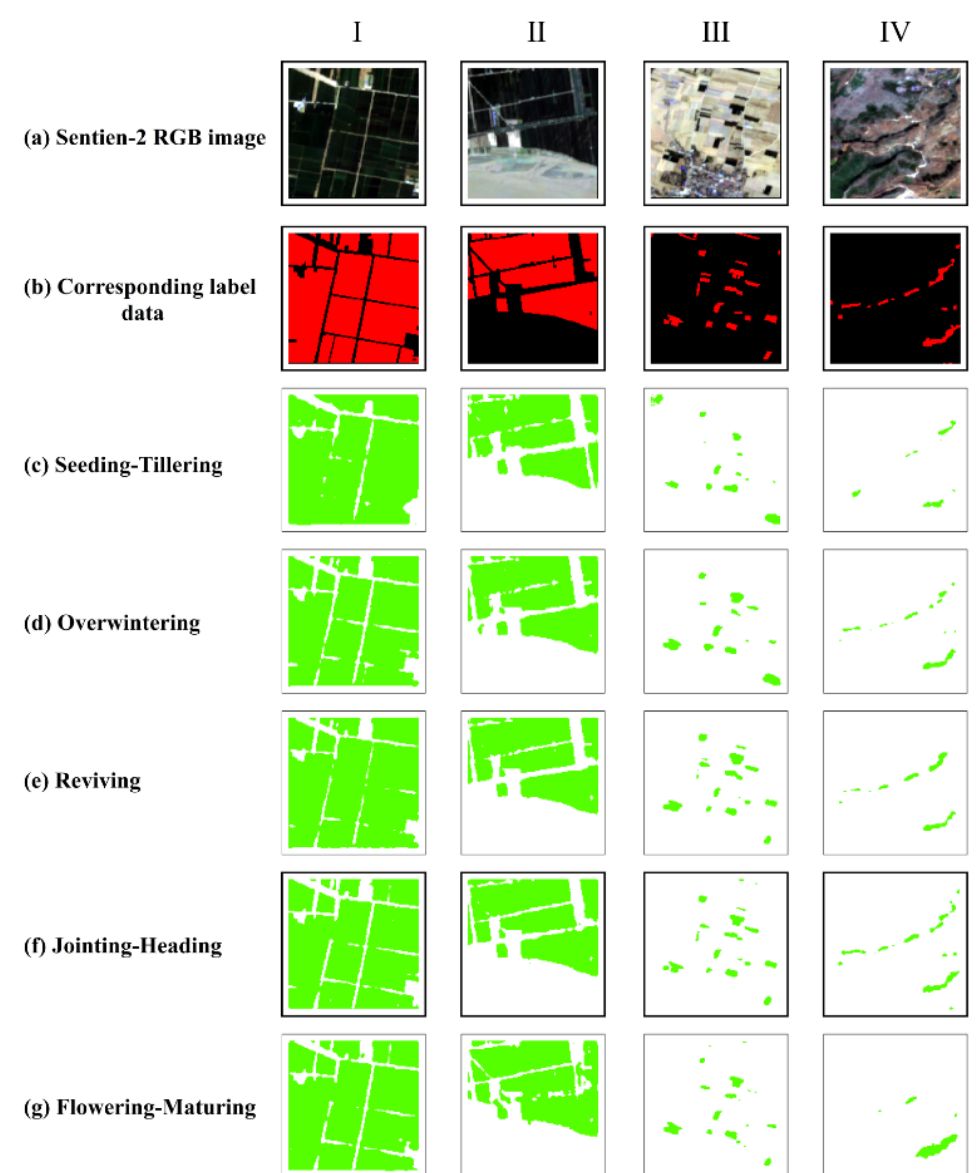
Figure 7. Results of the semantic segmentation of winter wheat using the test set. I-IV, respectively, represent winter wheat planting areas in an area of flat terrain, an area with multiple land-cover types, an area of fragmented terrain and an area of complex terrain. (a) True color Sentinel-2 composite images; (b) corresponding sample labels. (c)‒(g), respectively, show the results of the semantic segmentation of the sample data for the seeding‒tillering, overwintering, rejuvenation, jointing‒heading and flowering‒maturing periods.